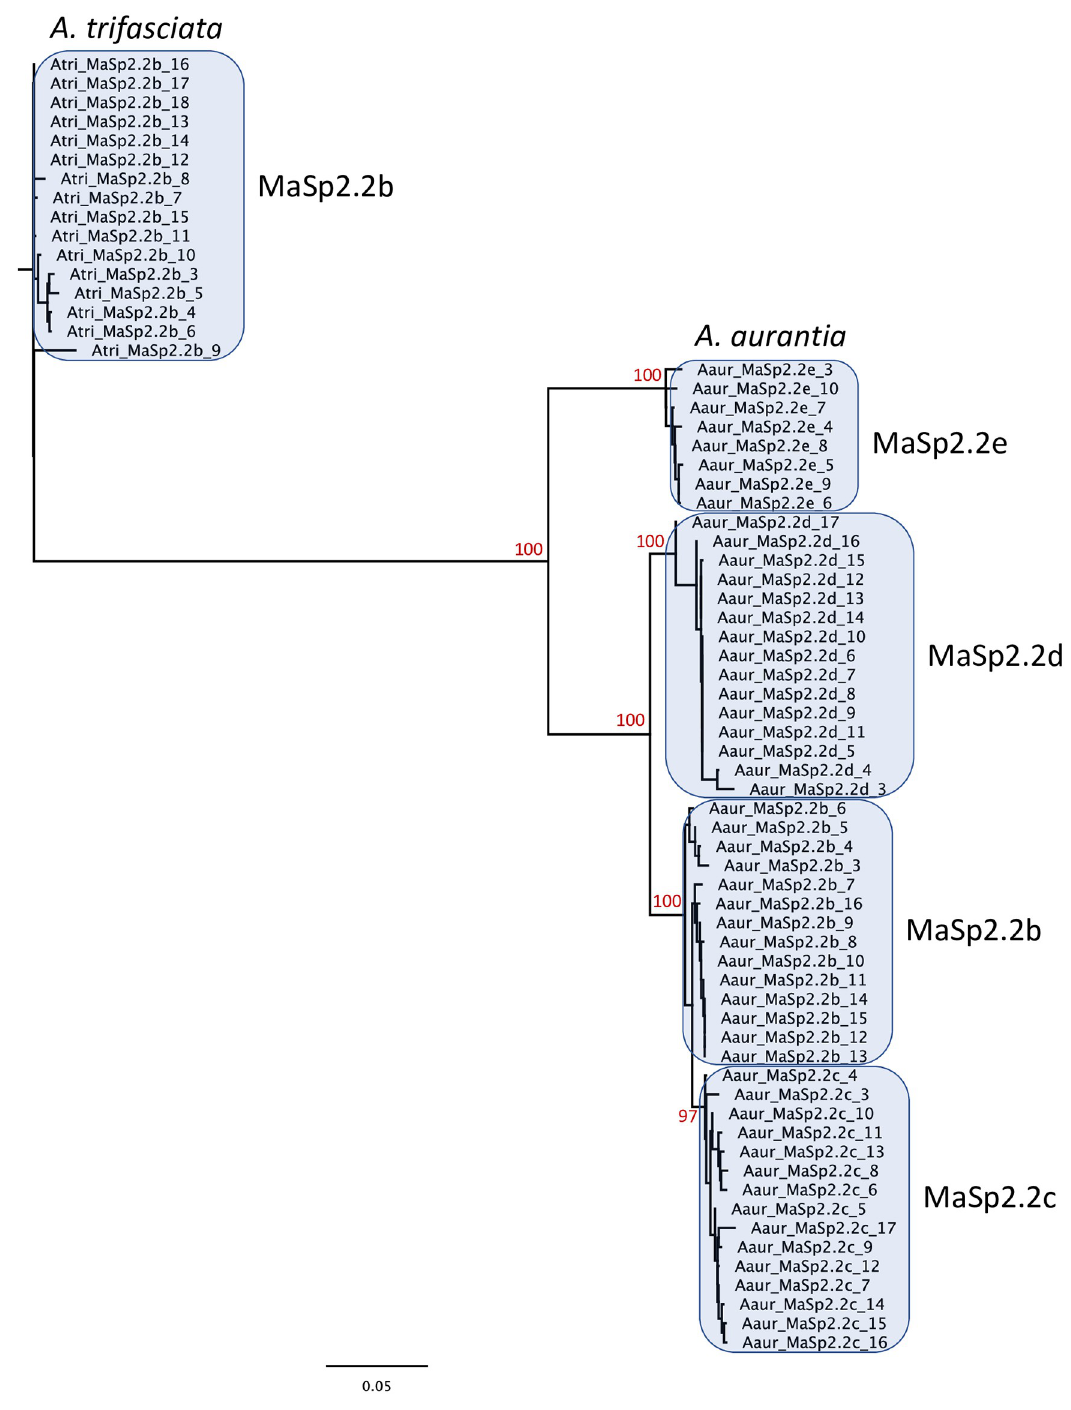
Fig 3. Sequence similarity among repetitive introns. Phylogenetic relationships among all the introns that belong to a specific homology group (introns of A . aurantia MaSp2 . 2b , MaSp2 . 2c , MaSp2 . 2d and MaSp2 . 2e , and A . trifasciata MaSp2 . 2b ). Generally, introns from a given gene belong to a strongly supported clade (bootstrap values provided at the nodes) indicating strong homogenization of these sequences.